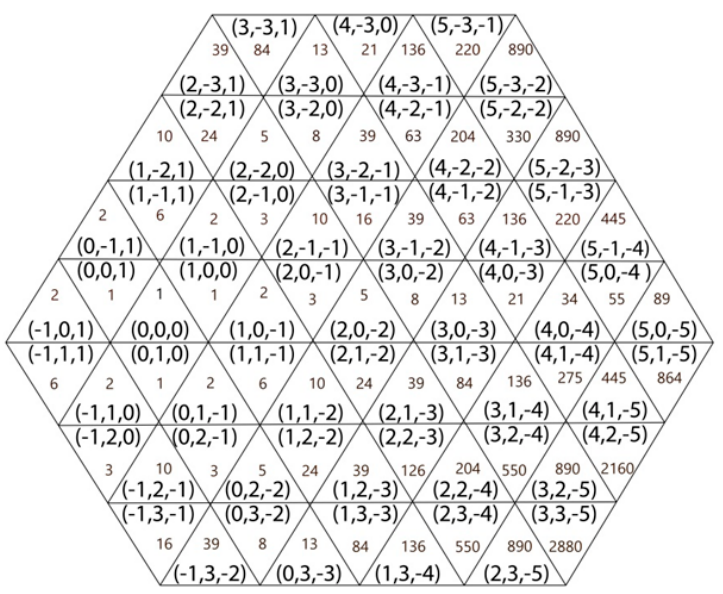
Figure 6. The number of the shortest weighed paths from trixel the origin to some other trixels with α = β and 3 α < γ the condition 2 α = β and 3 α < γ . the condition 2